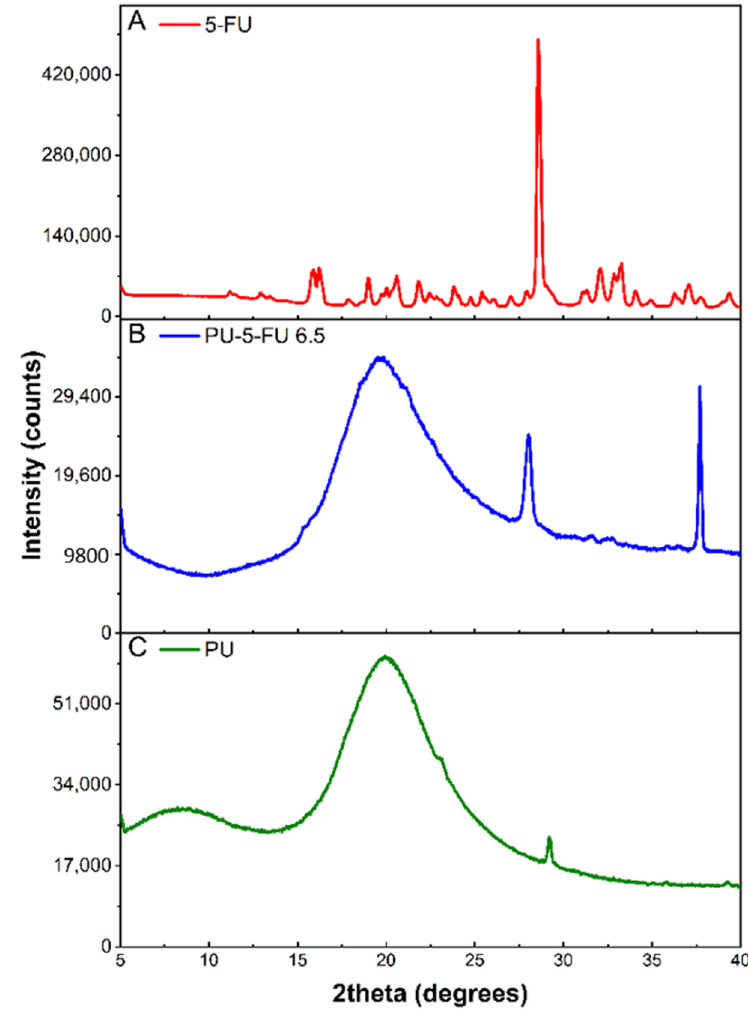
Figure 3. X-ray diffraction patterns of ( A ) pure 5FU, and ( B ) PU 5FU and (C) PU coatings.